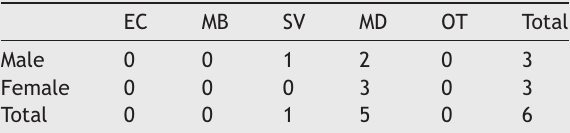
Numerical distribution of minor structural changes found regarding gender ( n = 56).